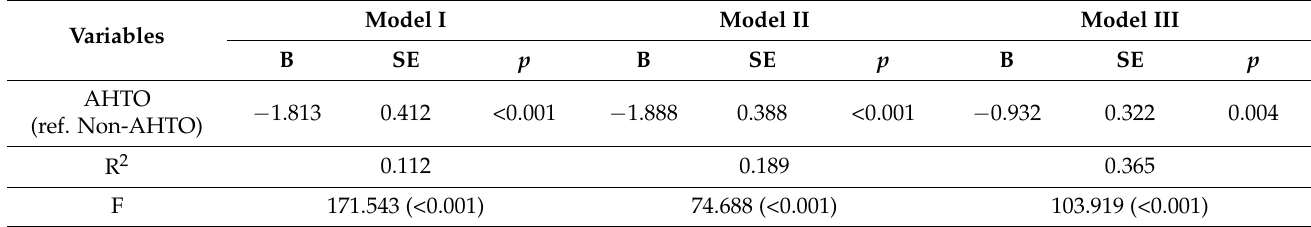
Table 2. Multiple regression analysis between exposure to AHTO and EQ-5D scores.